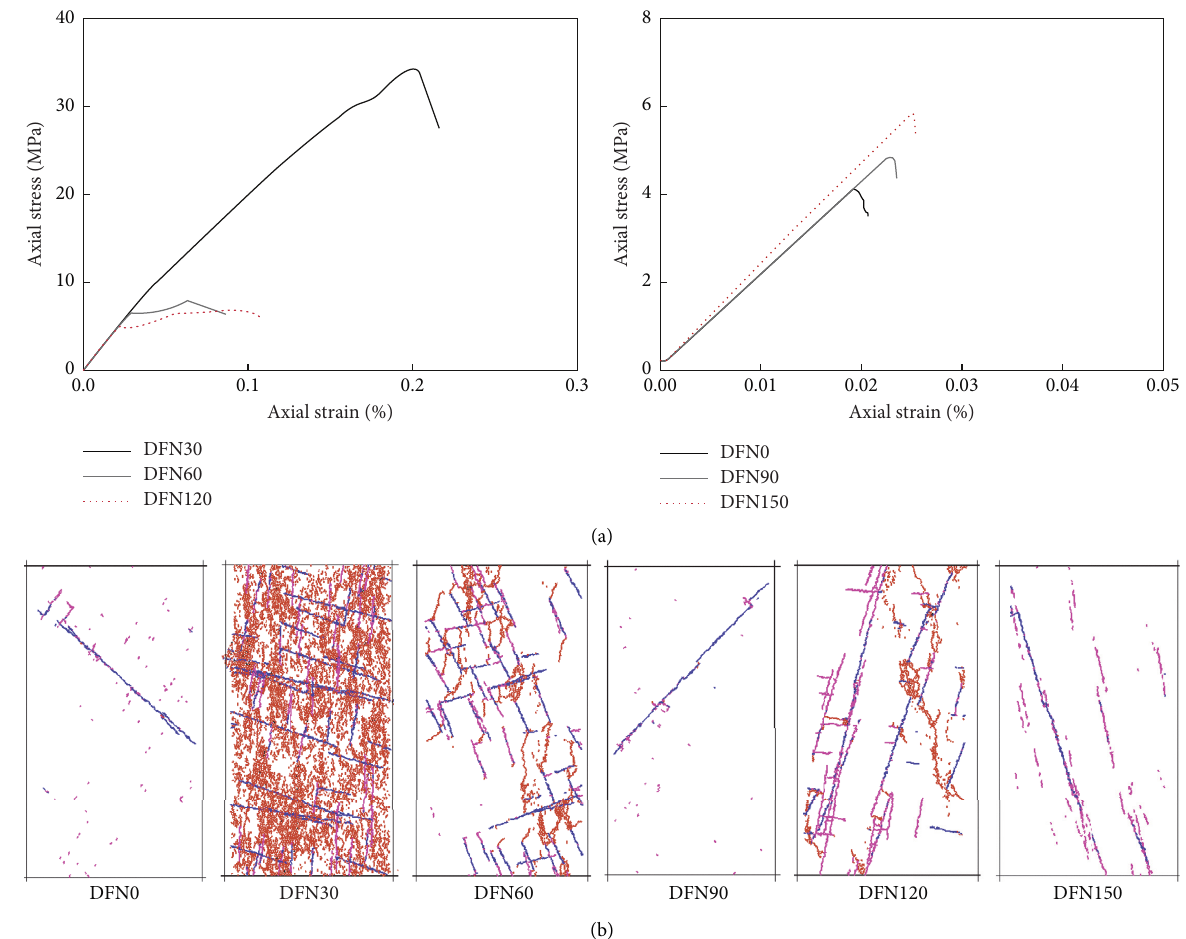
Figure 14: Uniaxial compression results for the specimen of size 5 × 10m under different loading directions. (a) Stress-strain curves under different loading directions. Note that the blue line is the SJM bond tensile crack, the magenta line is the SJM bond shear crack, the red line is the FJM bond tensile crack, the black line is the FJM bond shear crack, and the gray line is the model boundary. (b) Failure modes under different loading